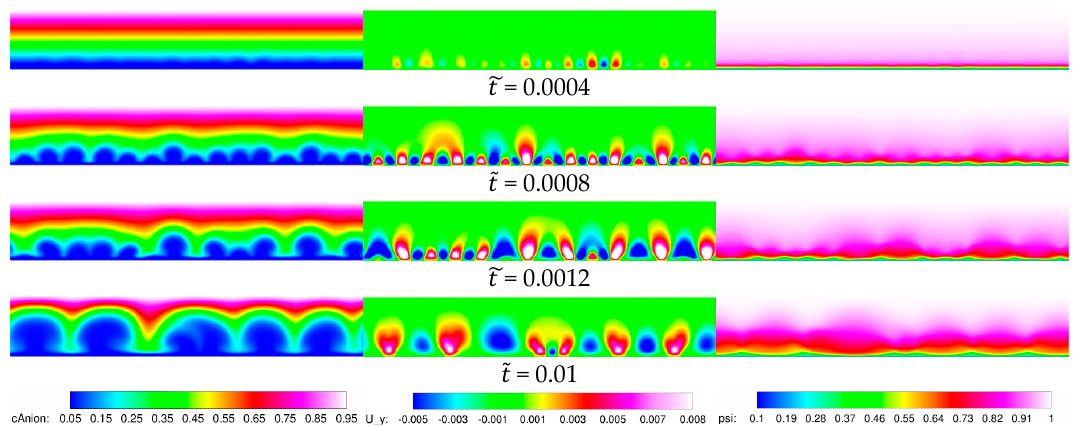
Figure 6. Baseline 2-D case, 𝑉 (cid:3556) = 40. Smooth membrane . From left to right: Anion concentration, vertical velocity in 𝑚/𝑠 , electric potential in 𝑉 .